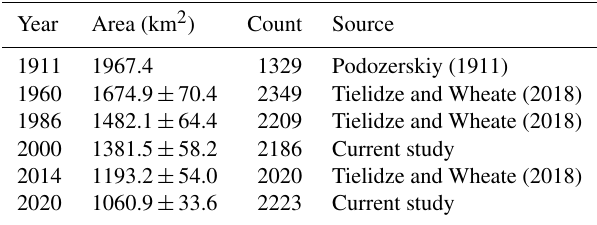
relative area and number of E- and W-exposed glaciers are very small (Fig. 6).